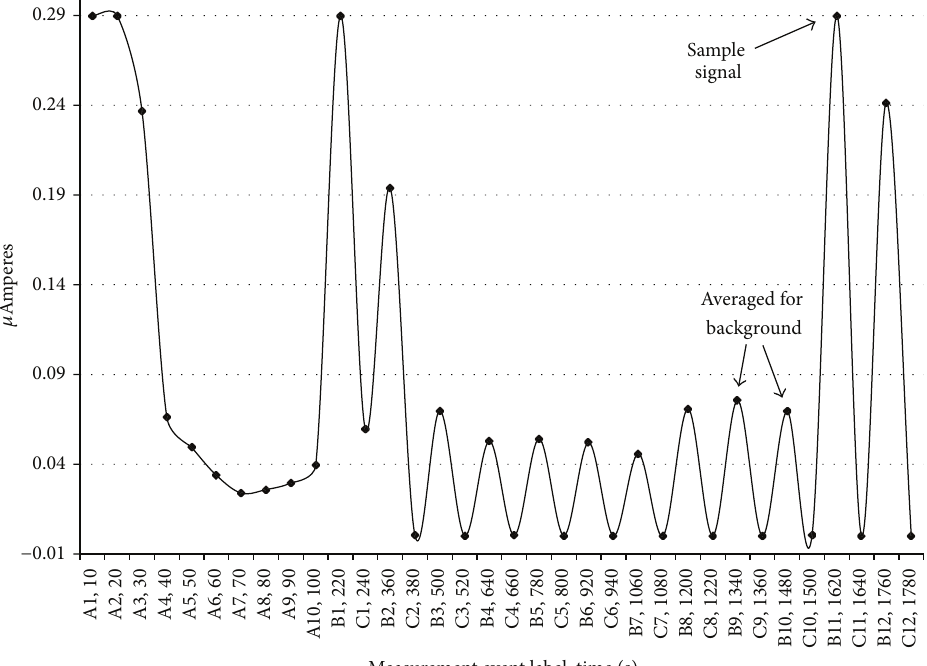
Figure 1: Amperogram of a typical PHAD run. Closed circuit measurements are indicated by a diamond symbol. Otherwise, the PHAD instrumentisin“opencircuit”modeduringwhichnomeasurementsoccur.A1–A10areusedtodischargetheelectrode.Duringmeasurements B1-C10 used blank substrate buffer is replaced with fresh (after C10 blank buffer is replaced with sample substrate buffer) 45–50 seconds prior to subsequent “B” measurement. Between B1 and C8, an offset knob is adjusted after each B, but before subsequent C measurement, to bring background near zero. Averaged background is subtracted from sample